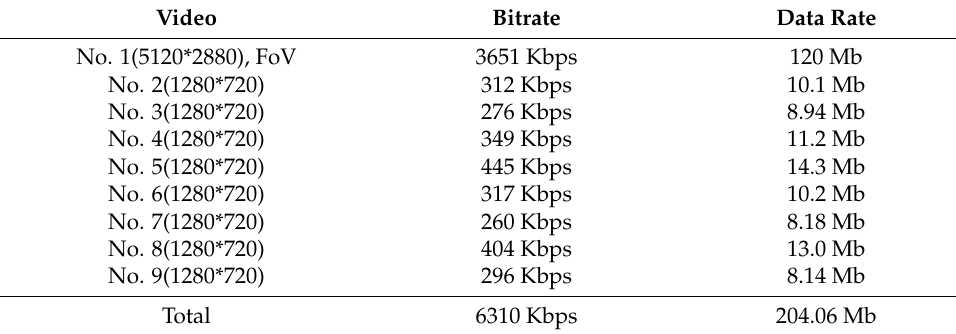
Table 3. Bitrate and size comparison for each of the 360 ◦ videos.